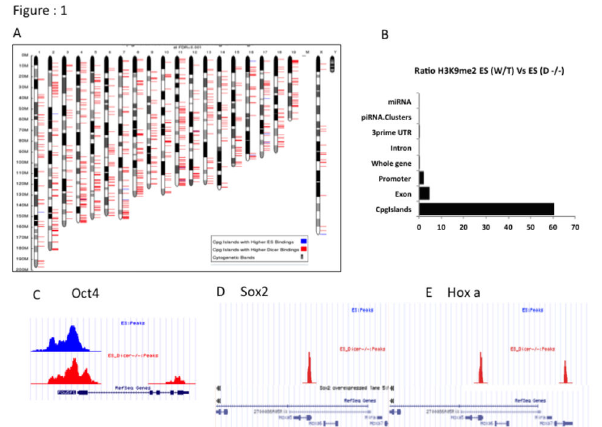
Figure 1. Dicer ’s effect on H3K9me2 distribution patterns in mES cells. A) Differential distribution of H3K9me2 in mouse chromosomes. Blue bars represent loci where higher enrichment levels were observed in mES cells while red bars represent loci where enrichment levels were higher in Dicer -/- ES cells. Specific genomic loci can be found in table S3 . B) Bar graph showing ratio of H3K9me2 occupation in Dicer -/- ES cells compared to WT ES cells in different genomic elements. C, D and E) Sequence tags from H3K9me2 ChIP-Seq experiment mapped to the UCSC genome browser to show enrichment at Oct4 and Sox2 and Hoxa gene cluster promoter regions of WT ES and Dicer -/- ES cells. Blue peaks represent WT ES cells and red peaks represent Dicer -/- ES cells.